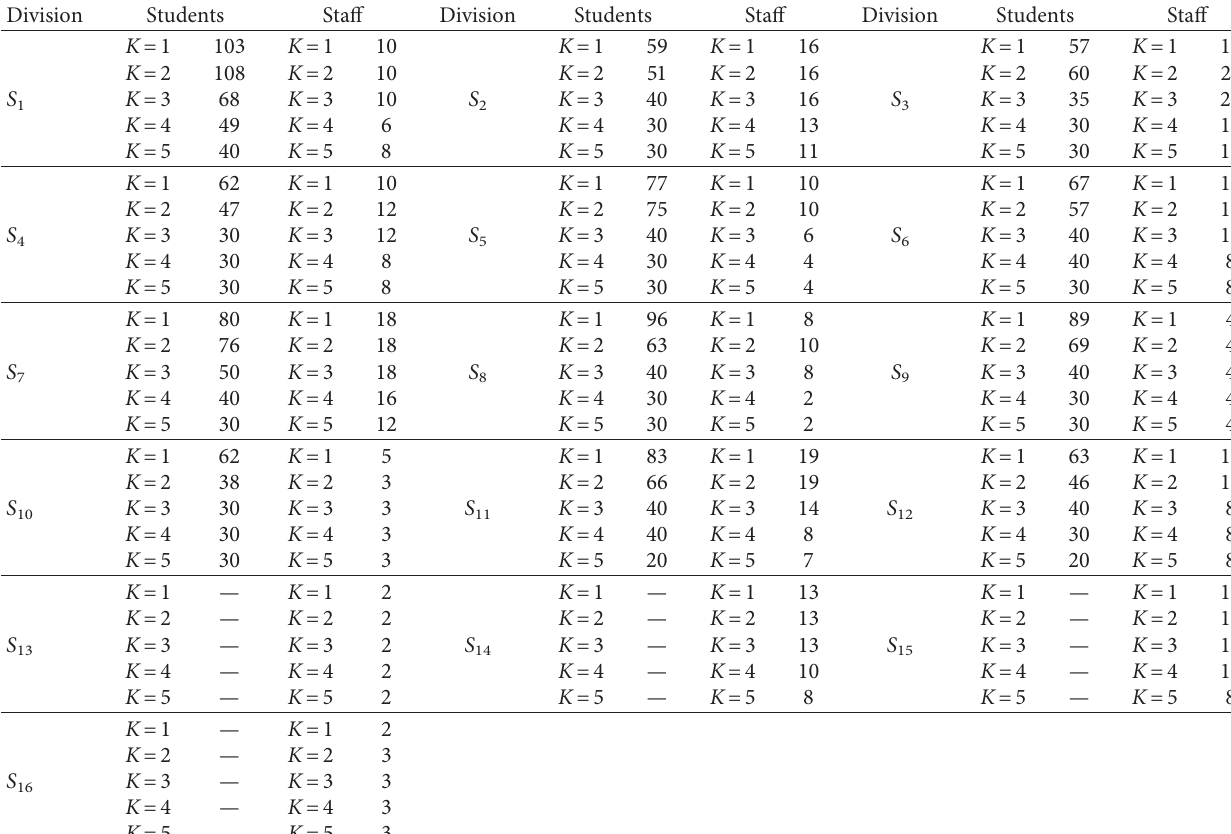
Table 13: Parking demand on Saturdays (staff and students).